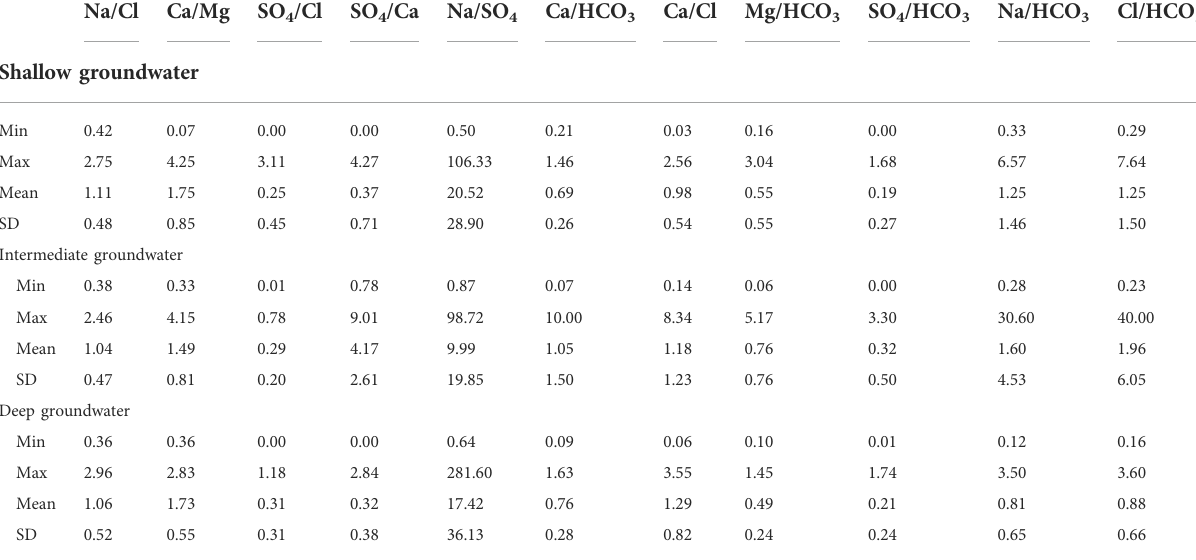
TABLE 5 Ionic ratios of the groundwater